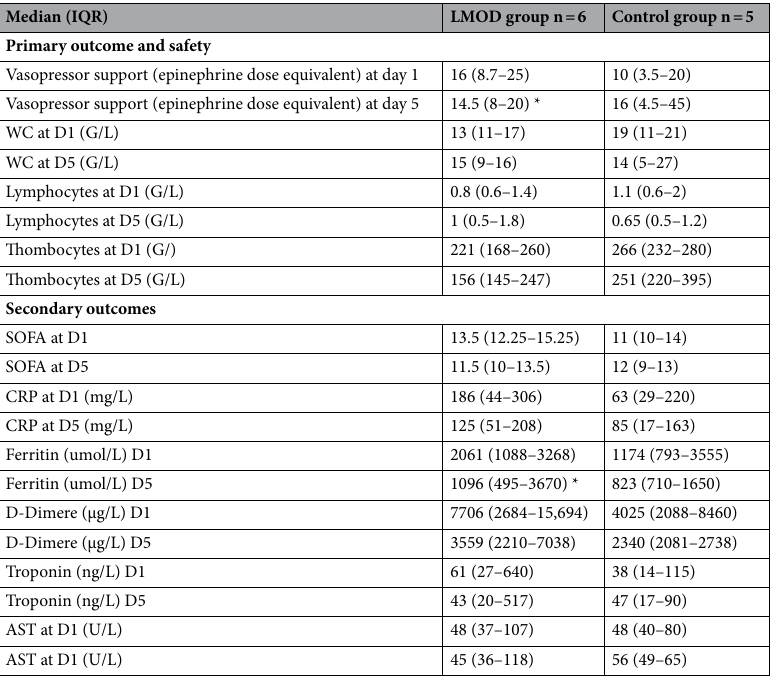
Table 2. Safety and outcomes. SOFA = Sepsis-related Organ Failure Assessment , WC = white blood cells, CRP = C-reactive protein, AST = Aspartate aminotransferase. *Friedman test, p significant for p <